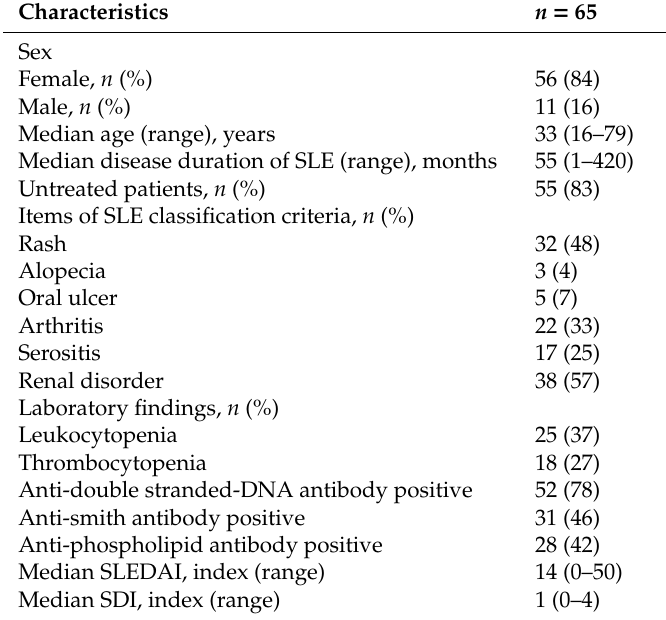
Table 1. General characteristics of 65 Japanese systemic lupus erythematosus